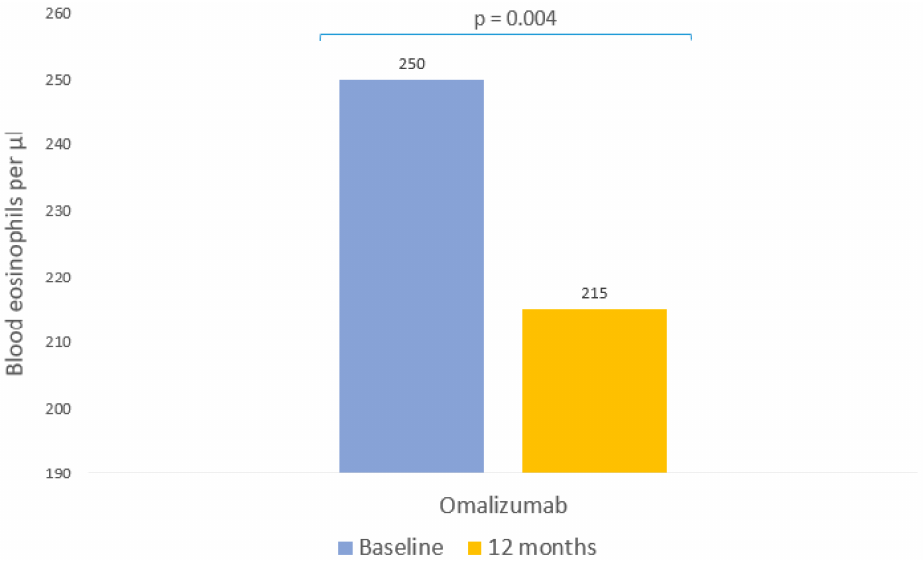
Figure 4. Clinical response to omalizumab: blood eosinophils. Median eosinophils prior to omali- zumab and after 12 months of treatment.